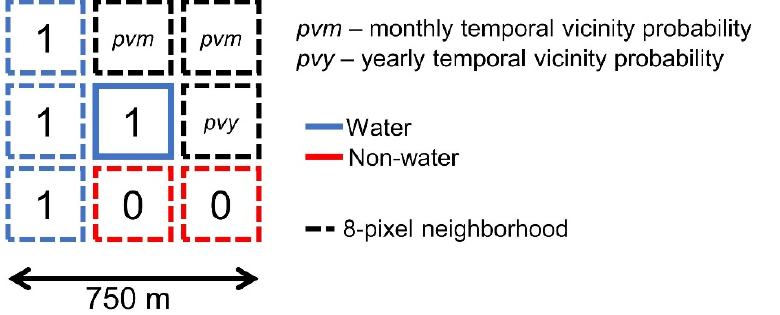
Figure 6. Example of the pixel neighborhood used for probability estimation. Here, three observations are invalid and, therefore, they were substituted using temporal vicinity estimates ( pvm , pvy ). Binary assessment: 1 ≙ true and 0 ≙ false.